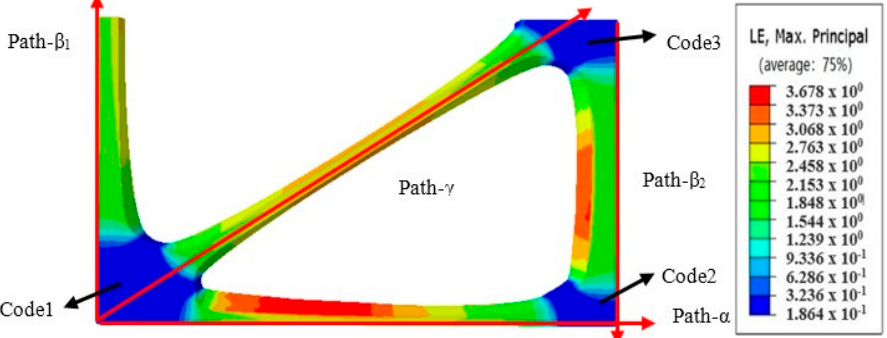
Figure 19. Path definition of performance optimization multi-axial geogrid.